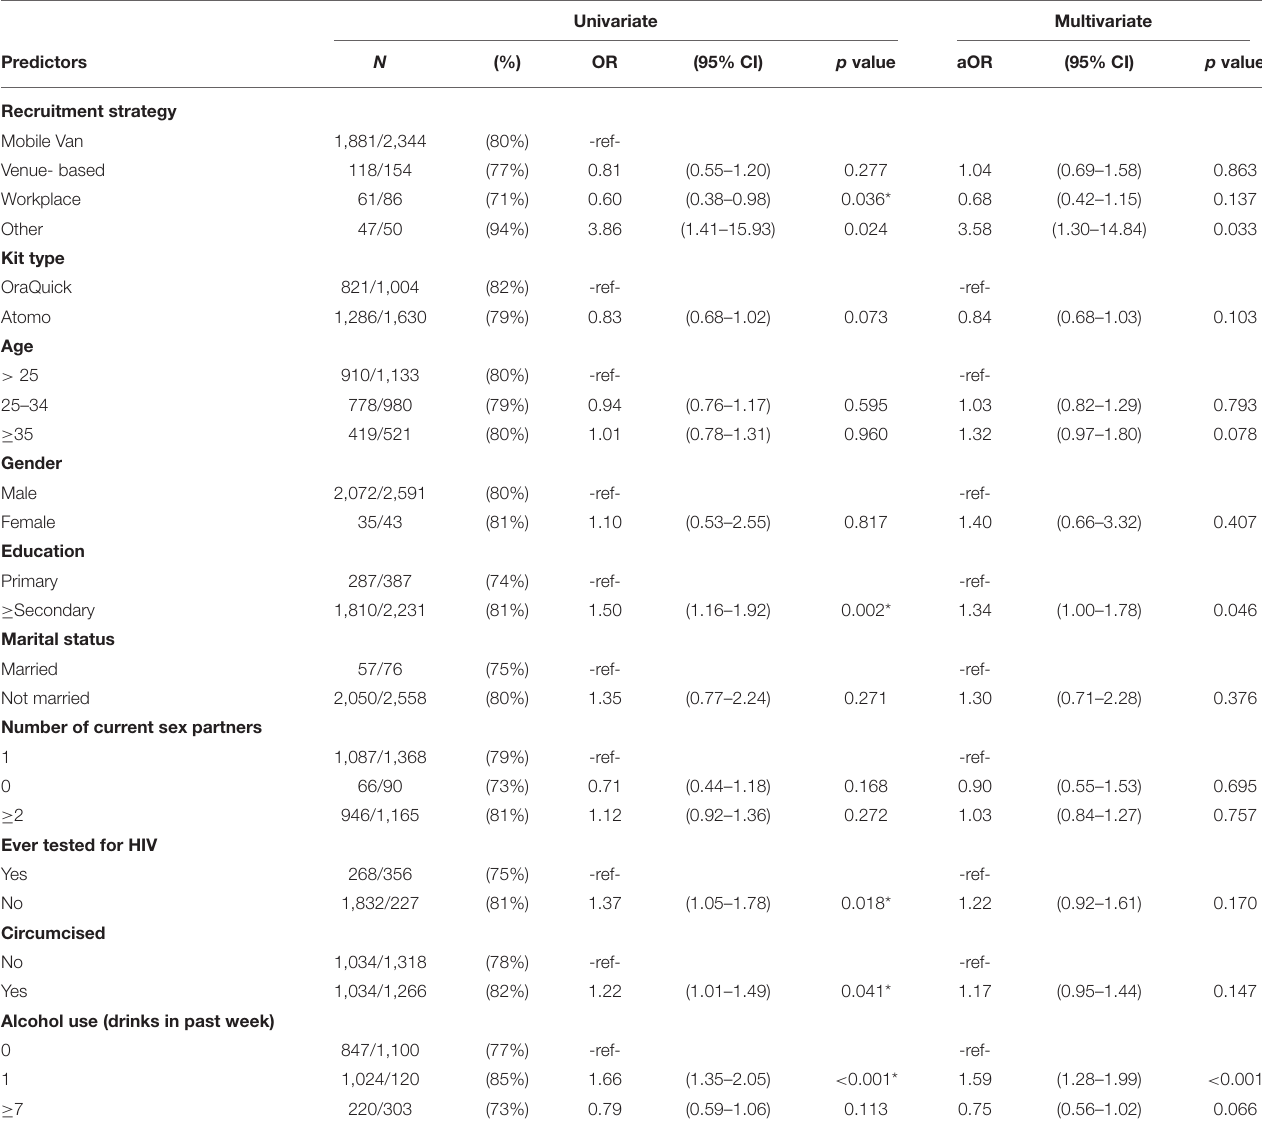
TABLE 2 | Characteristics of participants receiving an HIVST kit who reported HIVST results. Univariate